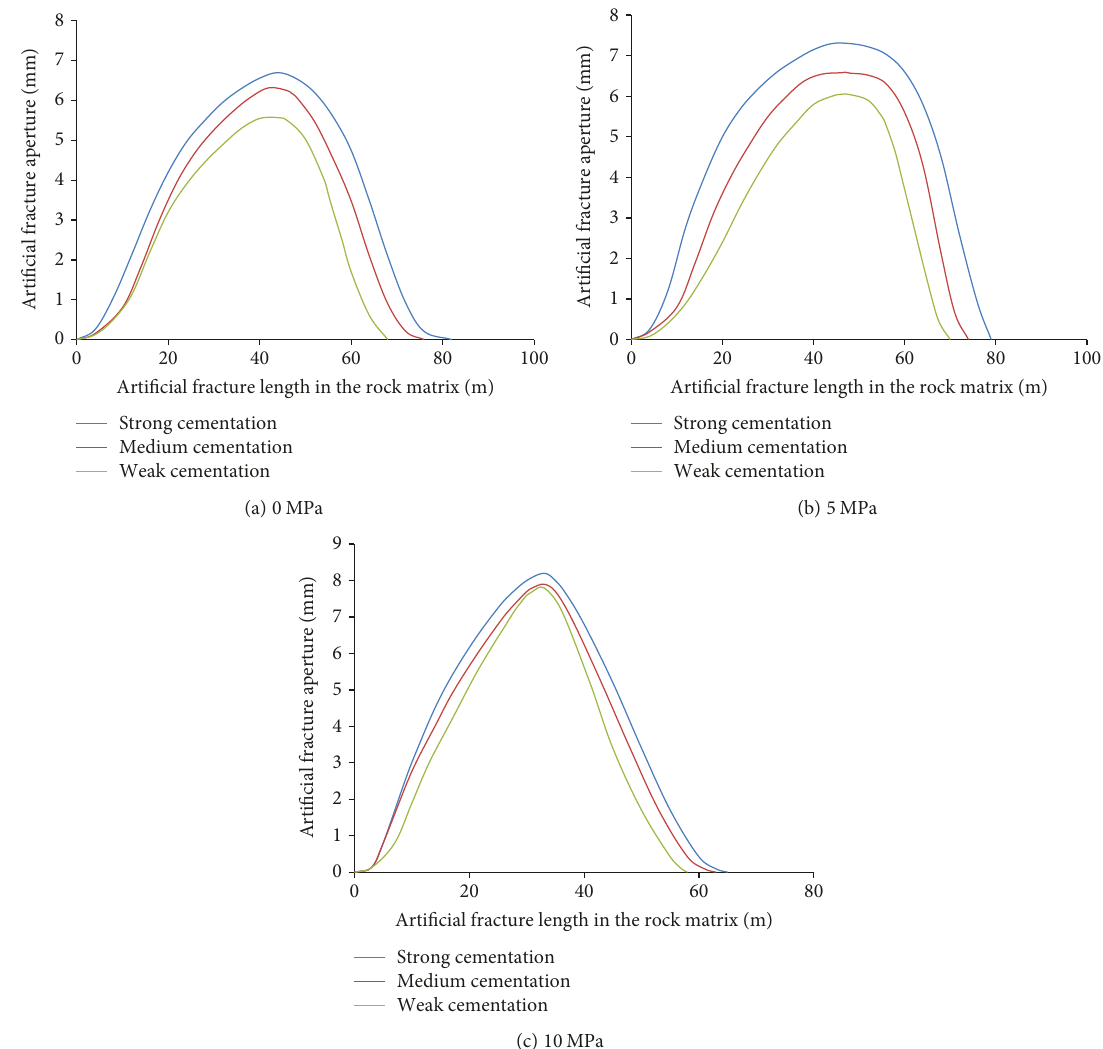
Figure 12: The in fl uence of cementation strength of a natural fracture on arti fi cial fracture propagation.